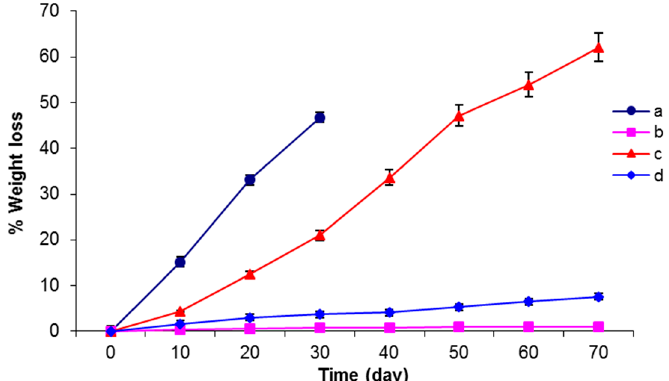
Figure 5. Percentage weight loss of virgin PLA and BF-PLA composites in control and real conditions. a, Virgin PLA in controlled composting condition; b, virgin PLA in real composting condition; c, BF-PLA composite in controlled composting condition; and d, BF-PLA composite in real composting condition.